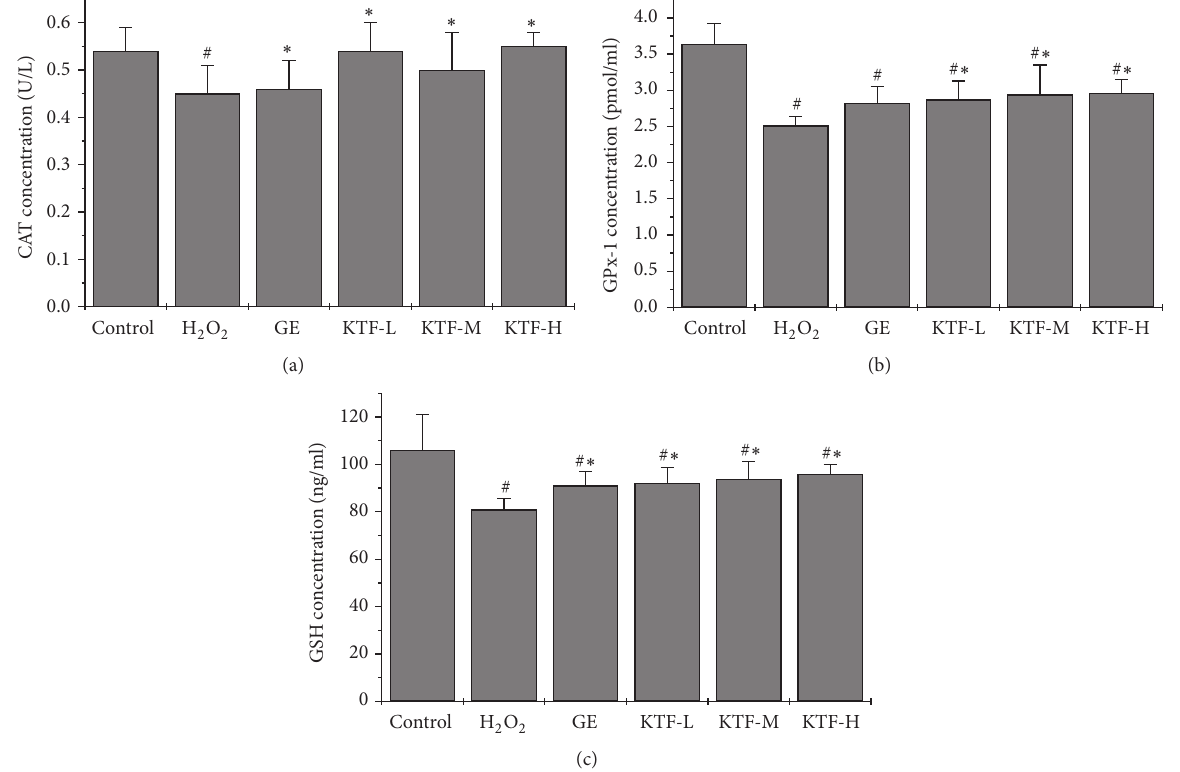
Figure 5: Effect of KTF on the level of intracellular CAT, GPx-1, and GSH in H 2 O 2 -induced MES23.5 cells. The activity level of intracellular CAT, GPx-1, and GSH was measured using an ELISA kit. Data are expressed as mean ± SD in three independent experiments. # 𝑃 < 0.05 compared to the control group. ∗ 𝑃 < 0.05 compared to the H 2 O 2 -treat